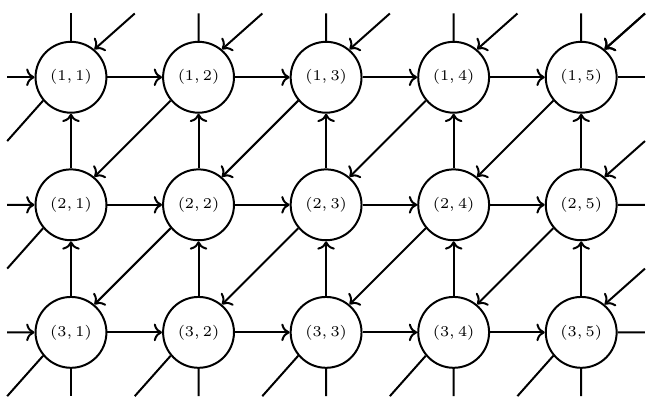
Figure 6. Section of the quiver diagram of the Z k × Z ‘ orbifold theory of N = 4 SYM. Circular nodes denote U( N ) vector multiplets and directed arrows denote chiral multiplets. Horizontal lines between node ( i, n ) and ( i, n +1) denote Q fields. Vertical lines between node ( i, n ) and ( i − 1 , n ) ( i,n ) denote Φ fields. Diagonal lines between ( i − 1 , n + 1) and ( i, n ) denote e Q fields. The quiver ( i,n ) ( i,n ) should be periodically identified in both directions, such that it has the topology of a tessellation of the